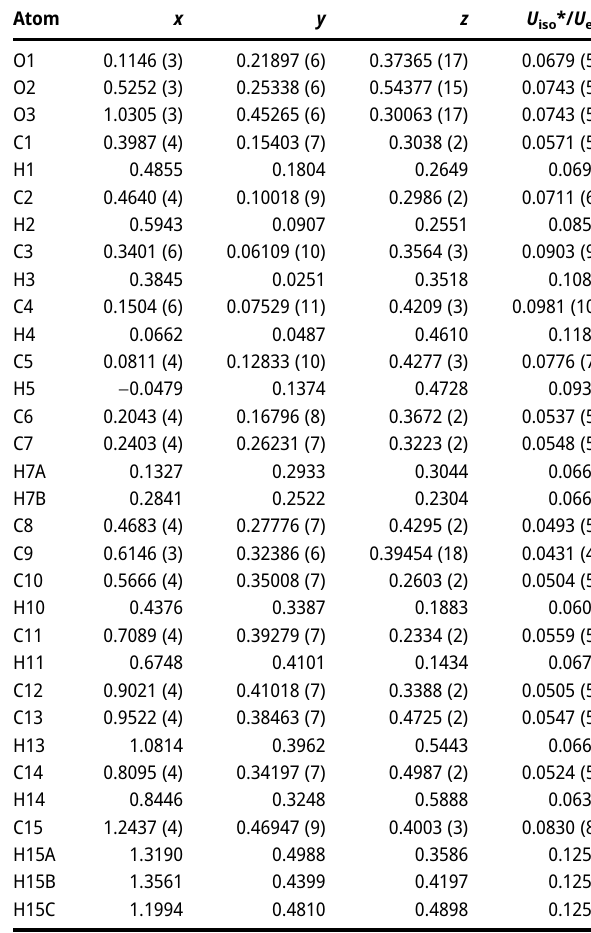
Table  : Fractional atomic coordinates and isotropic or equivalent isotropic displacement parameters (Å 